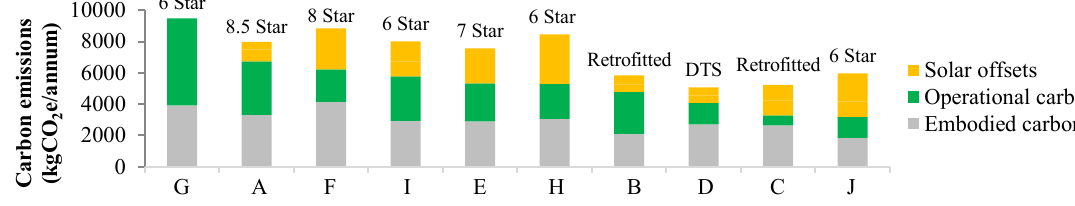
Fig. 4. Yearly carbon footprint and solar offsets.